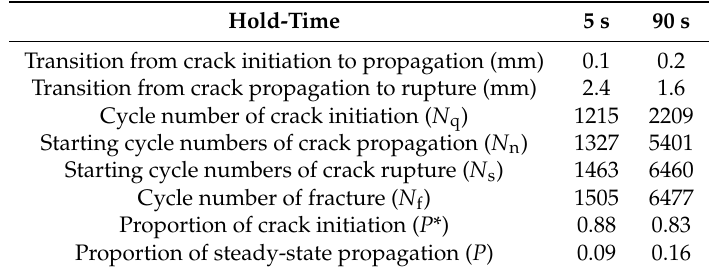
Table 3. Parameters corresponding to the crack-growth rates with 5 s and 90 s hold-times,